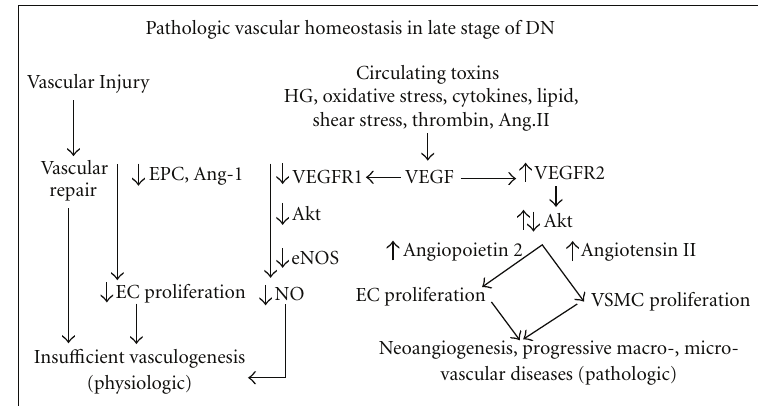
Figure 3: Pathologic vascular homeostasis in late stage of